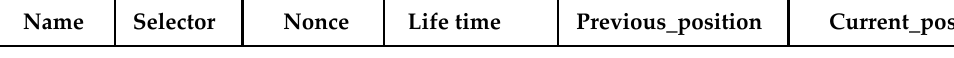
Figure 4. Control fields of Interest packets.